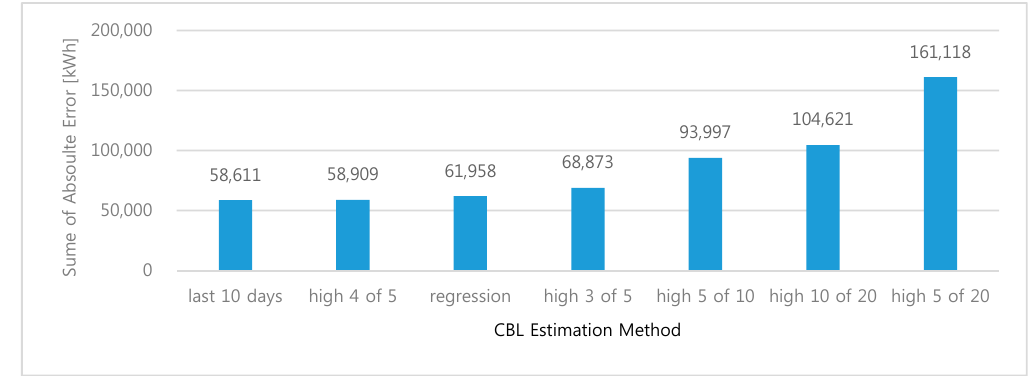
Figure 7. Sum of absolute errors for different CBL methods. Energies 2018 , 11 , x FOR PEER REVIEW